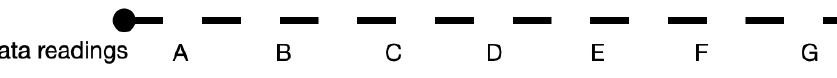
Figure 8. Data Readings Visualized.